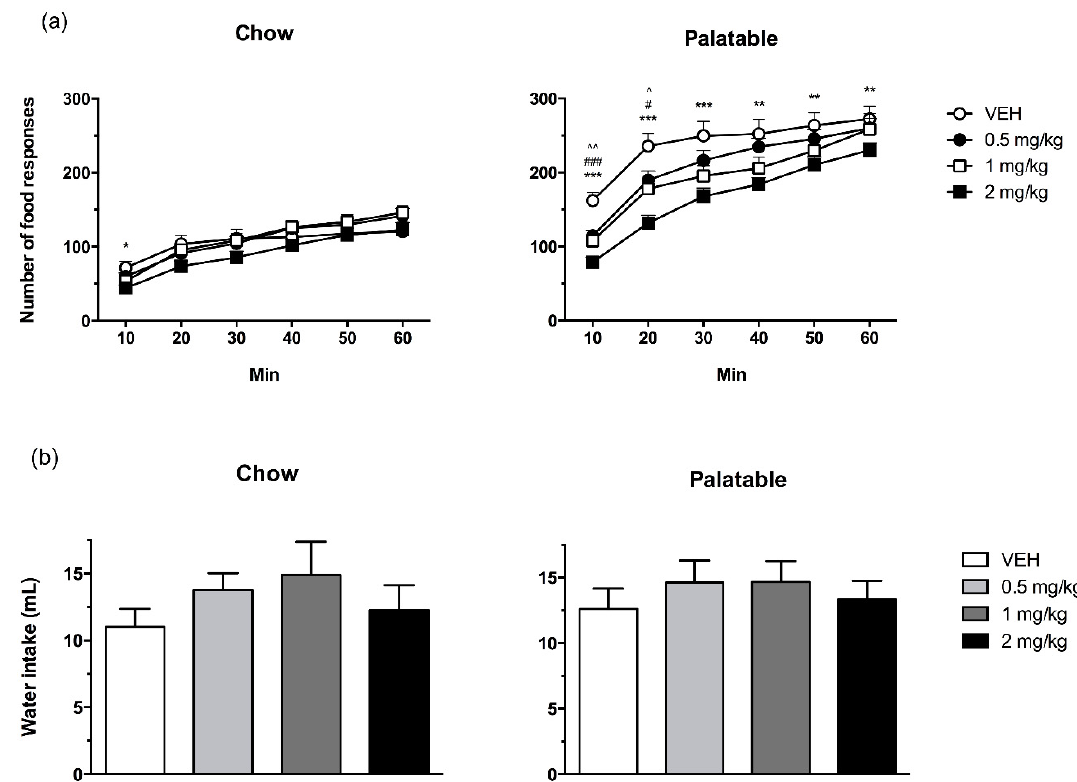
Figure 1. The effects of prazosin on food responses’ time course ( a ) and cumulative water intake ( b ) in Chow and Palatable rats in a fixed ratio 1 reinforcement schedule. Prazosin produced a more pronounced reduction in food responses in Palatable relative to Chow rats, but did not significantly affect water intake in either group. Data are presented as mean + SEM. Symbols indicate a significant difference from vehicle (VEH) within each group; 0.5 mg/kg: ^ p < 0.05, ^^ p < 0.01; 1 mg/kg: # p < 0.05, ### p ≤ 0.001; 2 mg/kg: * p < 0.05, ** p < 0.01, *** p < 0.001.